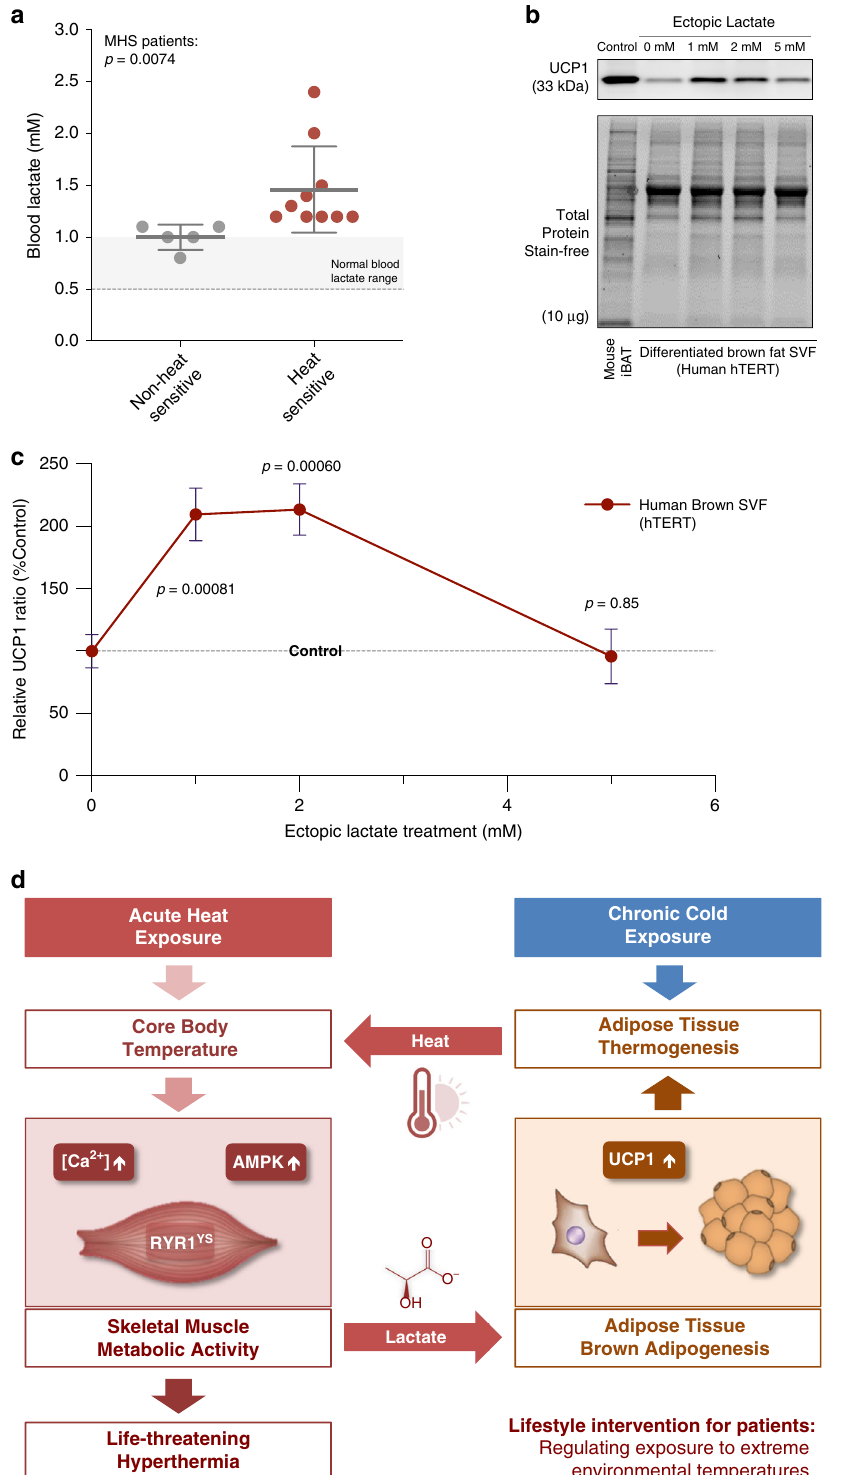
Fig. 9 Increased blood lactate in heat-sensitive MHS patients and its effect on human preadipocyte brown adipogenesis. a Blood lactate concentration of non-heat sensitive ( n = 5) and heat-sensitive ( n = 10) MHS patients carrying RYR1 variants. b , c Representative immunoblots ( b ) and relative protein levels ( c ) for the mitochondrial uncoupling protein (UCP1) in differentiation assay of immortalized human preadipocytes from stromal – vascular fraction of brown adipose tissue treated with vehicle control and different dose of ectopic lactate ( n = 5 each). d Proposed model of an adaptive thermogenesis enhanced feed-forward cycle of heat-induced heat response in susceptible patients. P values are indicated as Welch ’ s t test ( a , c ). All statistical tests are two-sided. Data are represented as mean ± standard deviation ( a ) and mean ± standard error of the mean ( c ). Relative protein levels are determined as levels normalized to the level of vehicle-treated controls ( c ). Source data are provided as a source data fi